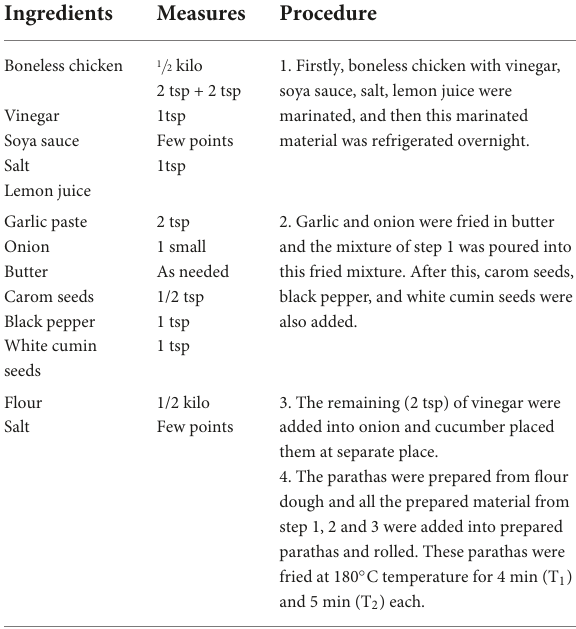
TABLE 6 Ingredients and procedure for preparation of paratha roll.